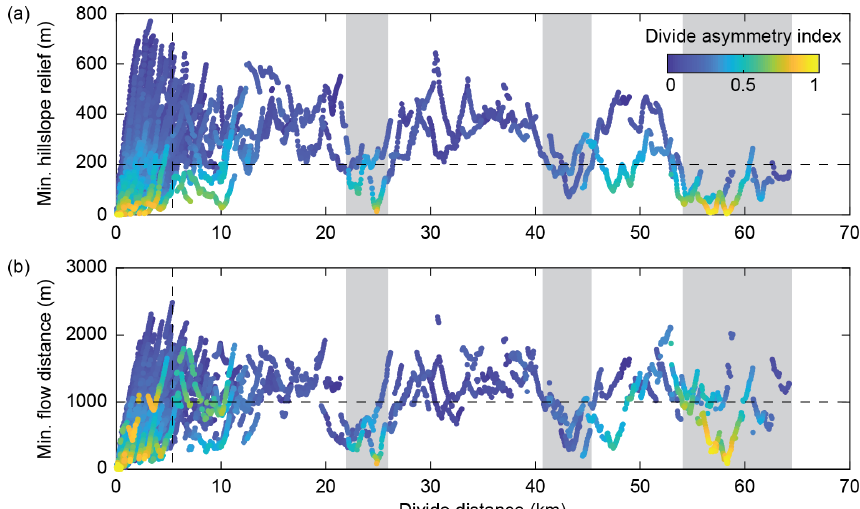
Figure 11. Minimum hillslope relief (a) and minimum flow distance (b) along the divide network of the Big Tujunga catchment. Colors denote the divide asymmetry index (DAI). Black stippled lines indicate the thresholds used to identify anomalous divides in Fig. 12. Gray- shaded areas highlight regions with anomalously low hillslope relief and flow